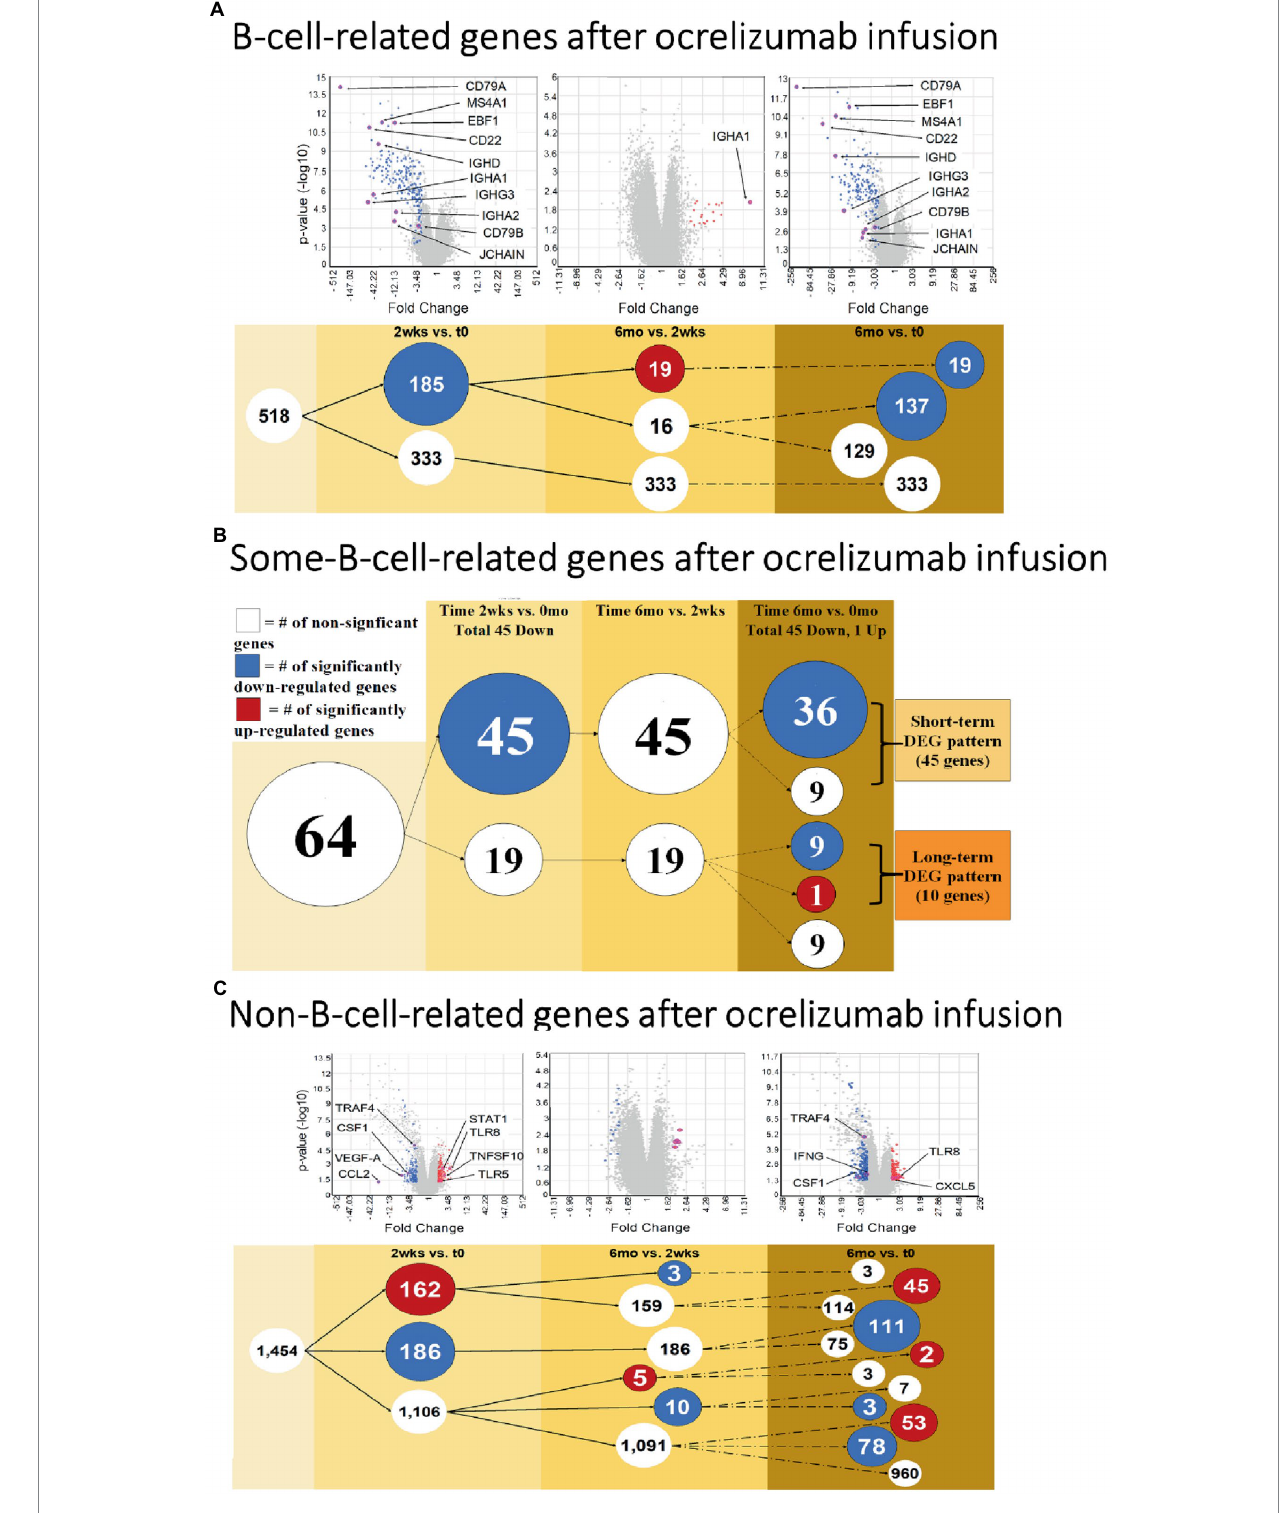
FIGURE 3 B cell and Non-B-cell gene expression in ocrelizumab-treated MS PBMC. (A) B-cell-related DEG decrease at 2 weeks and 6 months after infusion. Downregulation of gene expression predominates. (B) Some-B-cell-related gene expression in MS PBMC. Changes parallel (A) because loss of gene expression by B cells is the most visible effect of anti-CD20 B cell depletion. (C) Non-B-cell-related gene expression in MS PBMC. There is an increase of expression in some genes, unlike the B cell profiles. Red : genes pass FC > 2 and p < 0.05 criteria. Blue: genes pass FC < − 2 and p < 0.05. White: genes do not pass FC > |2| and/or p < 0.05. Venn sphere and font size reflects number of DEG. Labeled genes are discussed in text; All genes are listed in Supplementary Tables